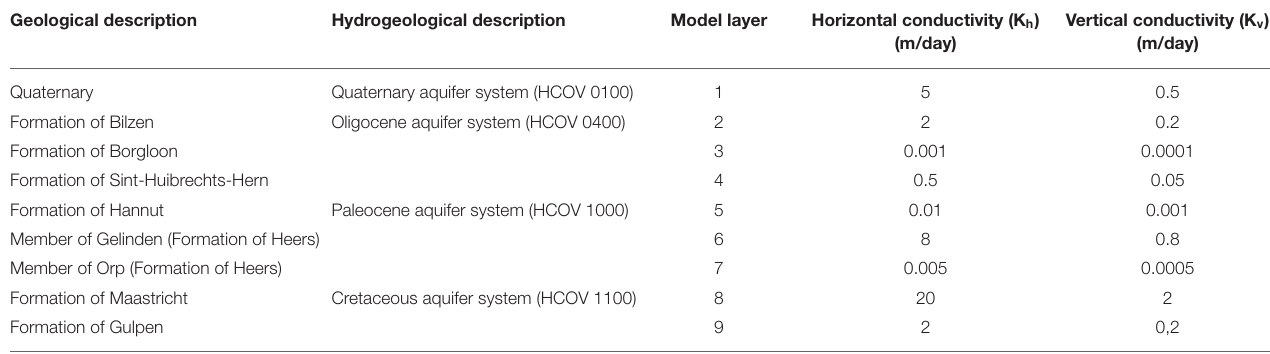
TABLE 1 | Initial horizontal and vertical hydraulic conductivity of the cretaceous. Geological